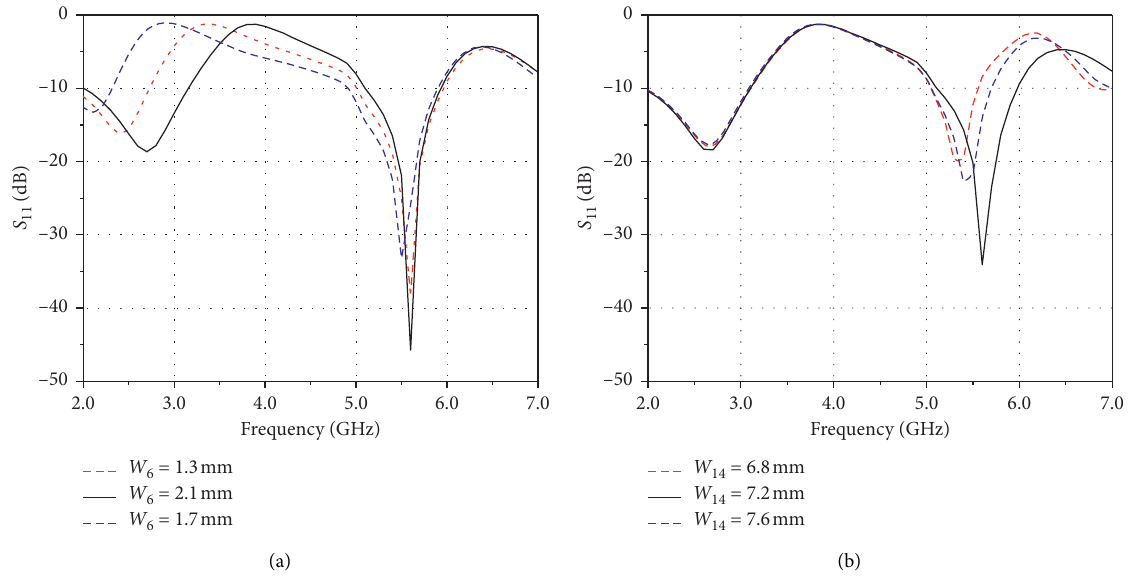
Figure 4: Simulated reflection coefficients for different values of (a) W